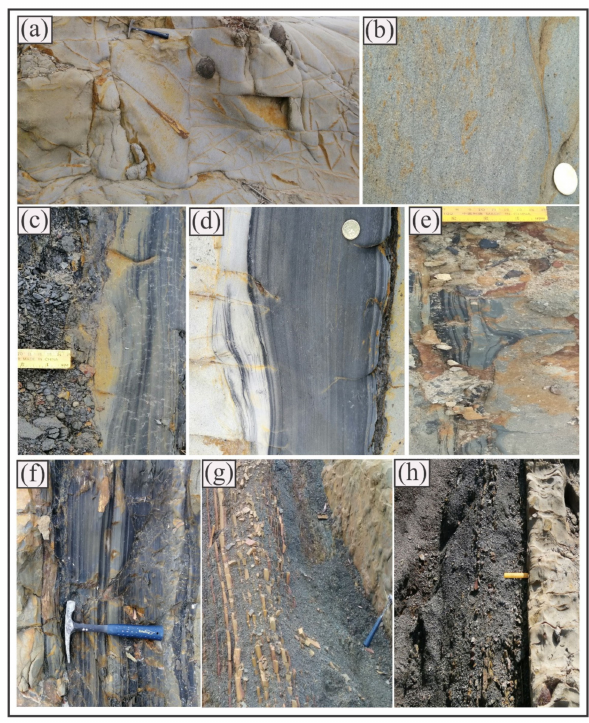
Figure 4. Sedimentary facies. ( a ) Amalgamated massive sand with floating mud clasts in the Jalan UMS road section, interpreted to be S1 lithofacies. ( b ) Massive, coarse-grained sandstone at the Jalan UMS road section, which belongs to the S2 facies. ( c ) Parallel lamination S3 facies and cross- lamination S4 facies in the Jalan UMS road section. ( d ) Parallel laminated S4 facies at the Jalan UMS road section. ( e ) Flame structure S5 facies. ( f ) Laminated siltstone facies Si1 at the Jalan UMS